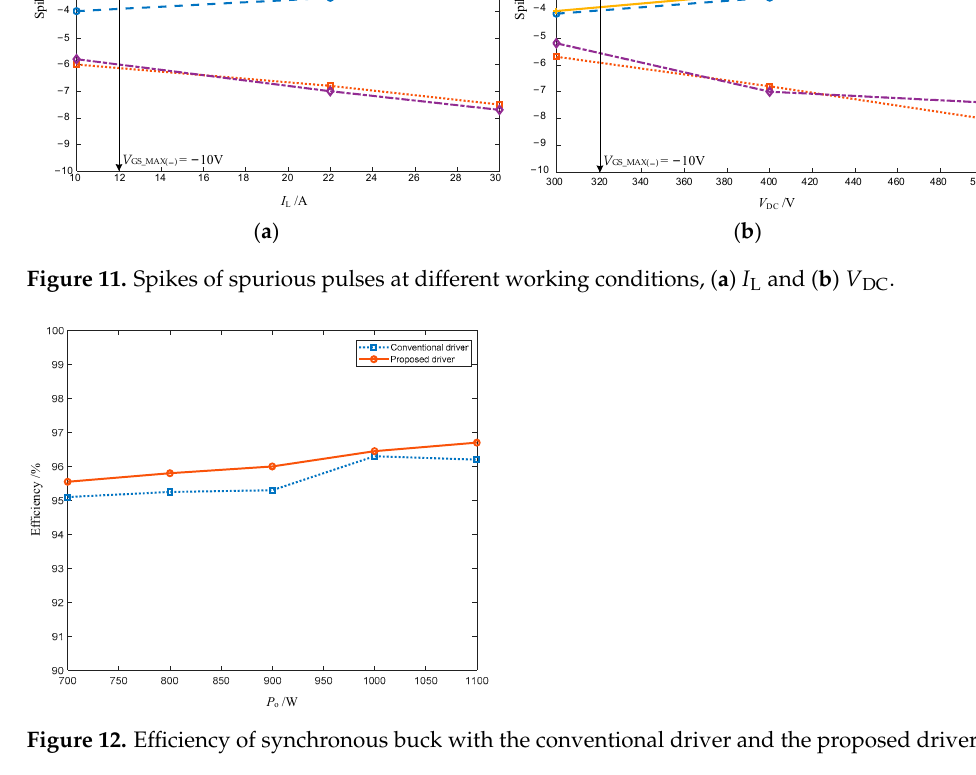
Table 5. Efficiency tested conditions of synchronous